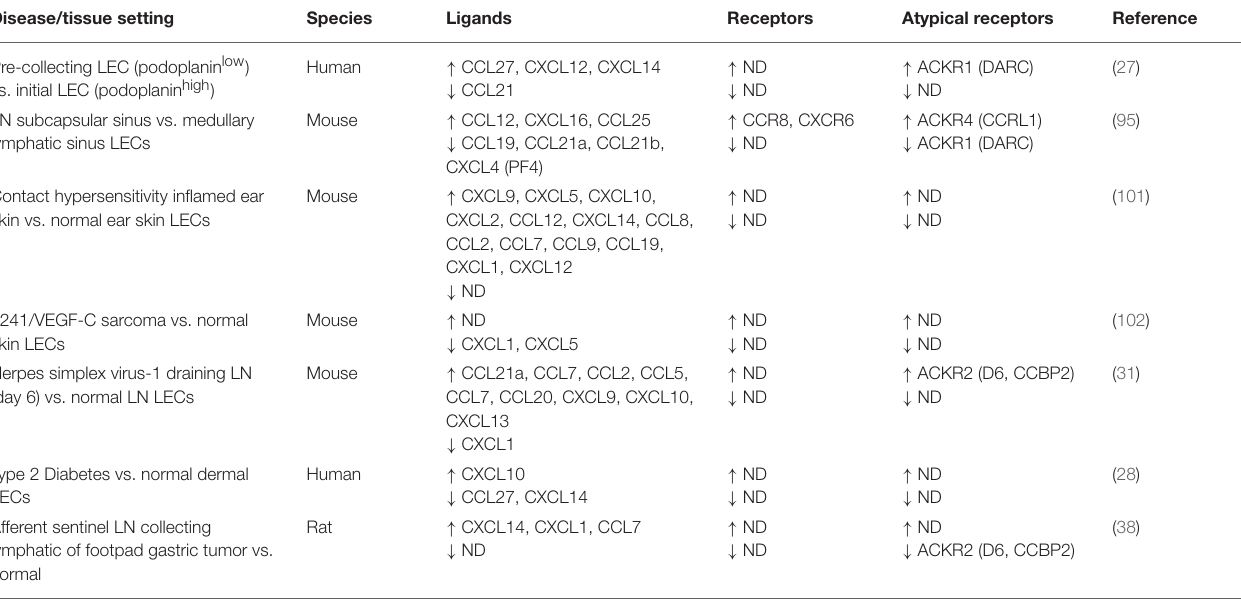
TABLE 2 | Chemokines and receptors differentially expressed in physiological and disease-associated LECs. Disease/tissue setting Species Ligands Receptors Atypical receptors